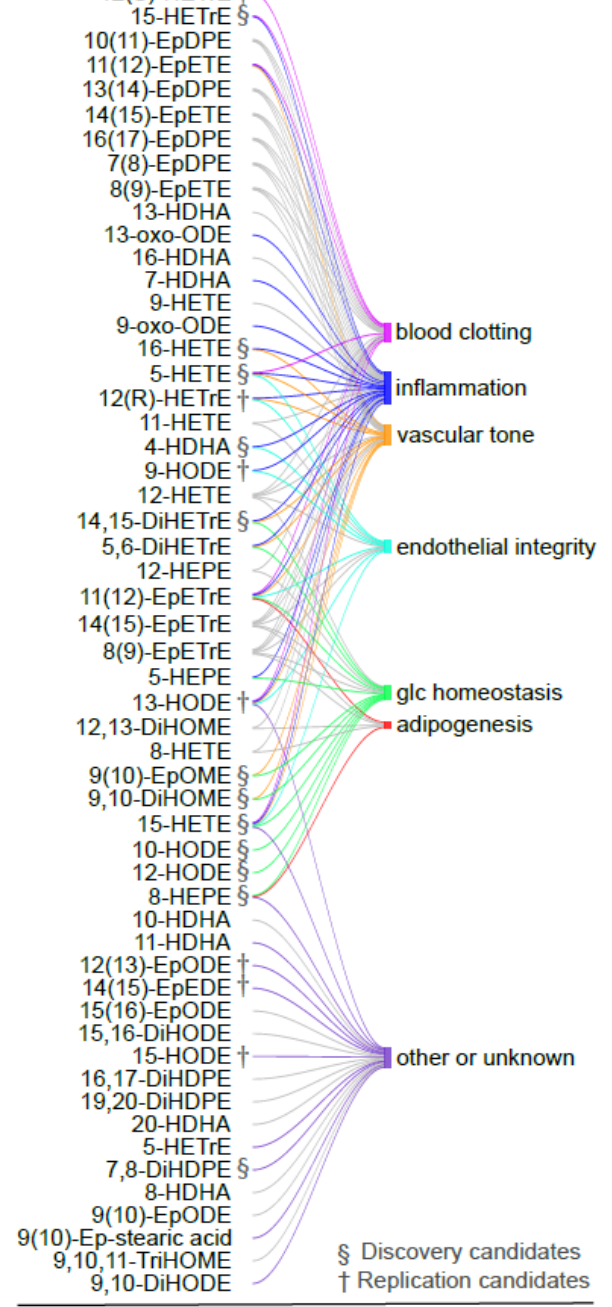
Figure 4. Biological functions of the candidate oxylipins discriminating participants with MetS. Sankey plot showing the relationships between the 54 oxylipins in the Discovery and Replication studies and the biological functions related to MetS (i.e., inflammation, vascular tone, blood clotting, endothelial permeability, adipogenesis and glucose homeostasis). The oxylipins selected in the Discovery and Replication studies ( n = 29) have their links highlighted in color. Relationships were established based on a systematic manual literature search including 110 references (~2 studies/oxylipin). For 47% of these studies, experiments were realized using human in vitro models whereas 5.4% used in vivo human experiments and 27% were realized using in vivo animal experiments. The package R “stringr” was used to establish the links between the oxylipins and the cardiometabolic functions, then the package “googleVis” was used to generate the Sankey plot.